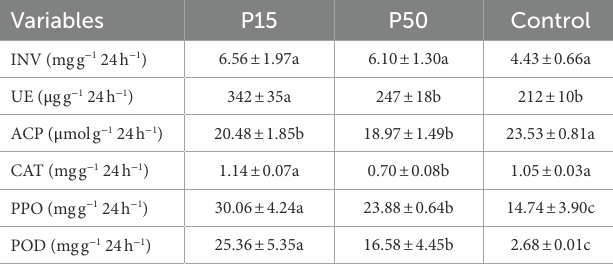
TABLE 2 Soil enzyme activity in the Cinnamomum camphora coppice planting. Variables